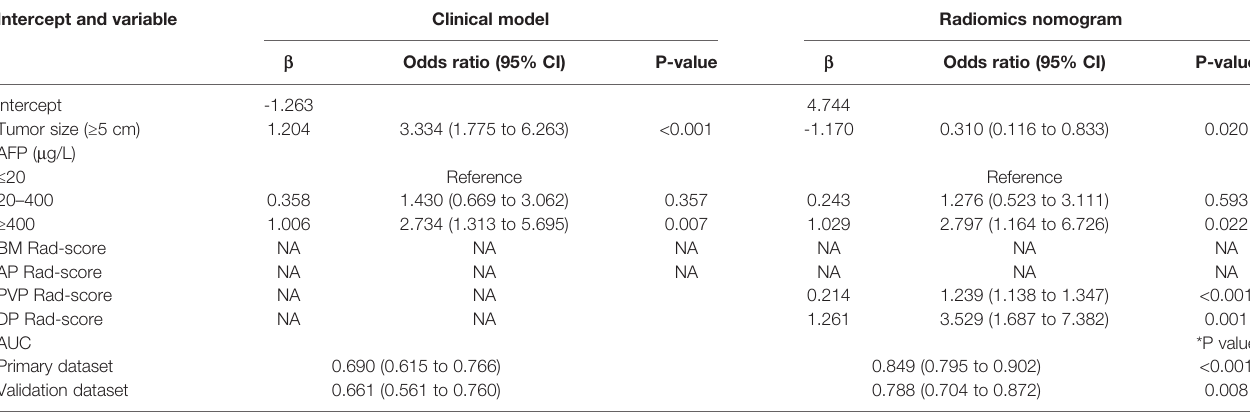
TABLE 3 | Variables and coef fi cients of the radiomics nomogram and clinical model. Intercept and variable